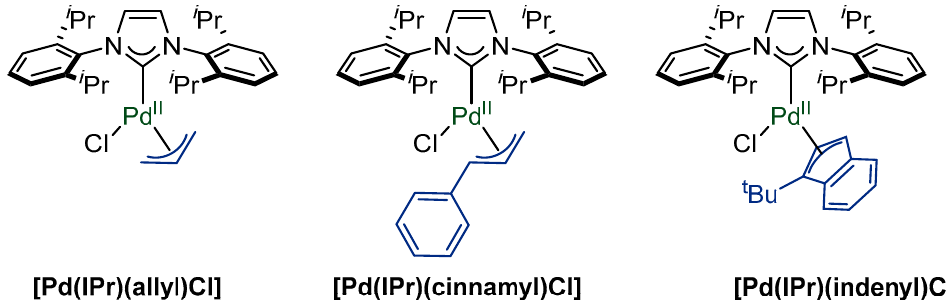
Figure 2. Pd(allyl)NHC pre-catalysts employed in the cross-coupling of amides.